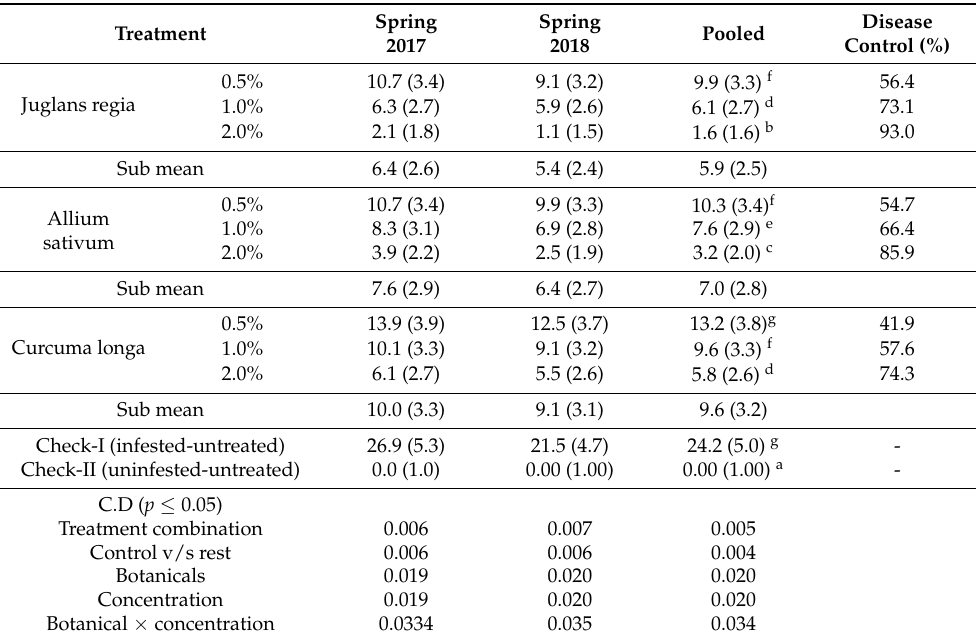
Table 4. In vivo efficacy of botanical extracts on severity (%) of green mold of button mushrooms at 0.5 to 2% concentration.